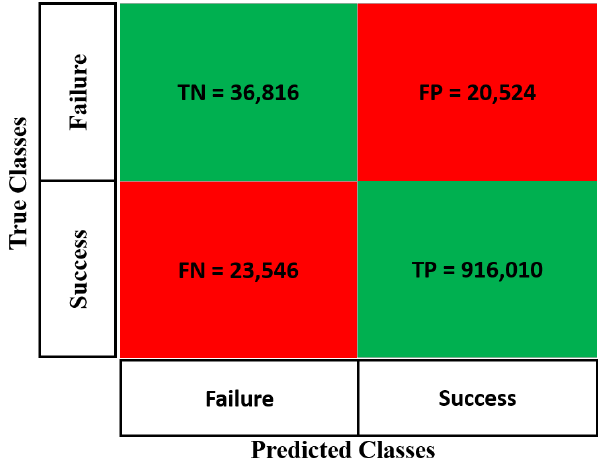
Figure 12. Confusion matrix for SVM